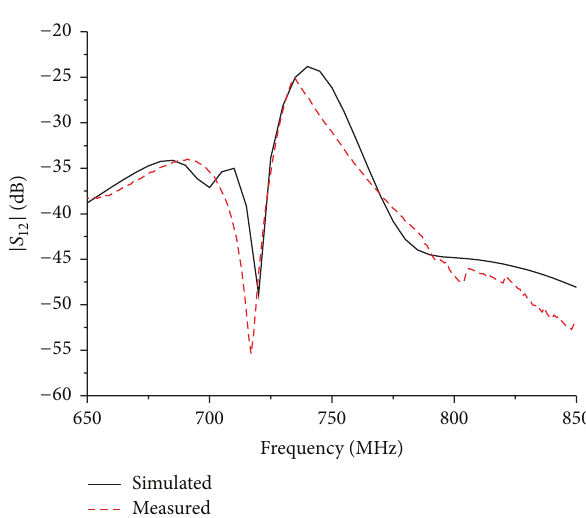
Figure 9: Simulated and measured |𝑆 12 | of the proposed antenna.